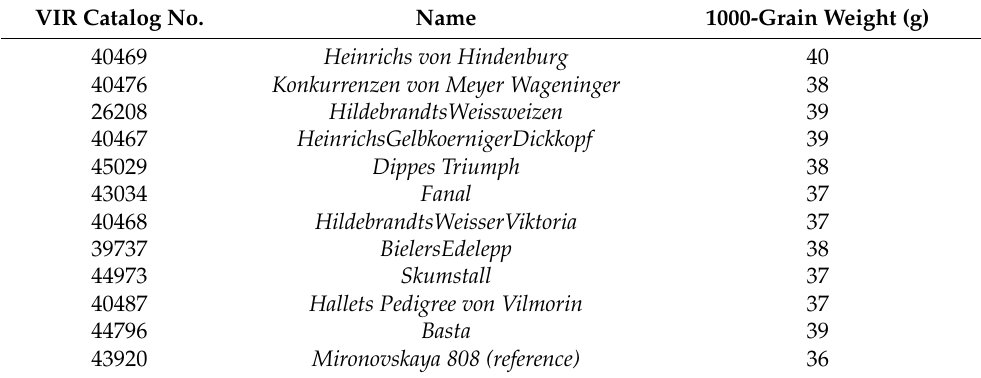
Table 1. German winter wheat samples with largest grains that stood out in terms of drought resistance